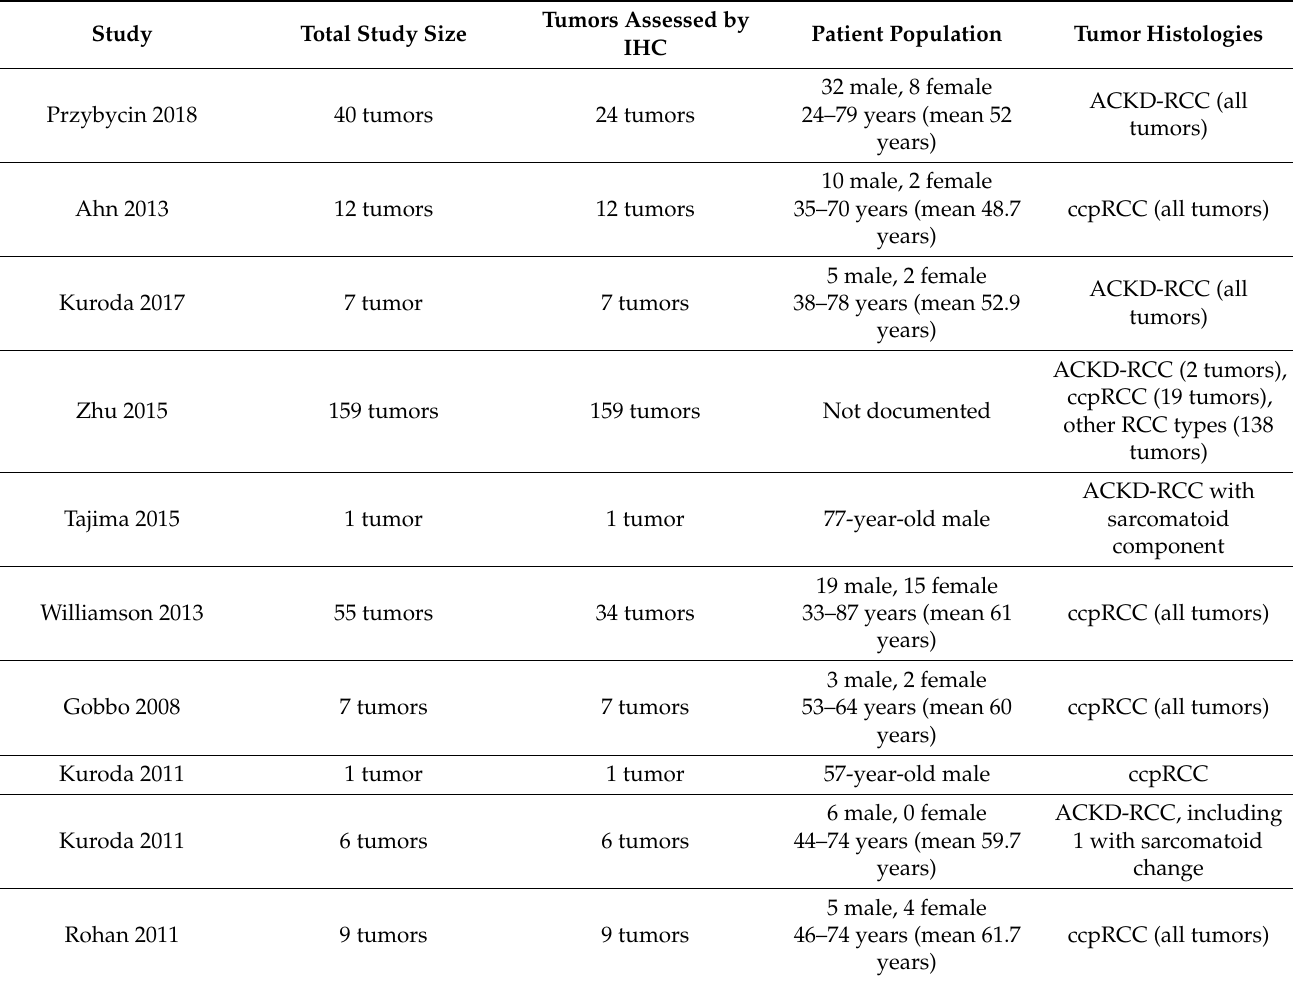
Table A1. Supplementary information from studies of immunohistochemistry in ESRD-associated